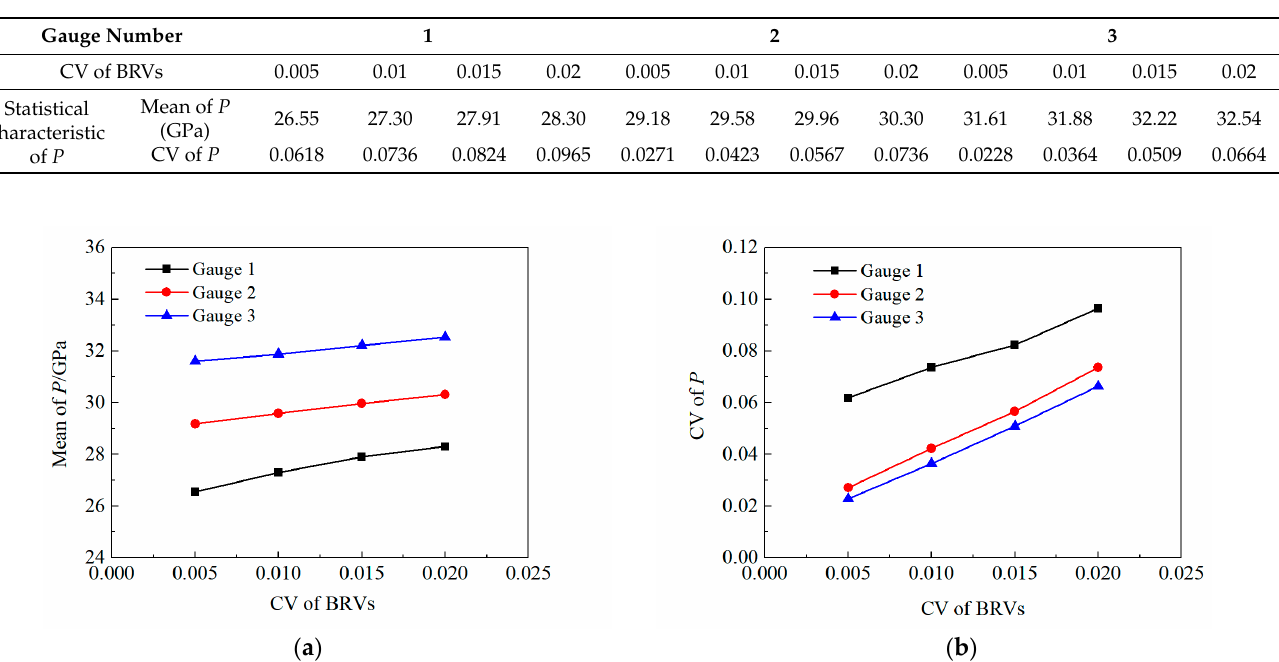
Table 8. The calculation results of the GABP-MCS in the DPR study under the shock load condition where v is 1050 m/s.